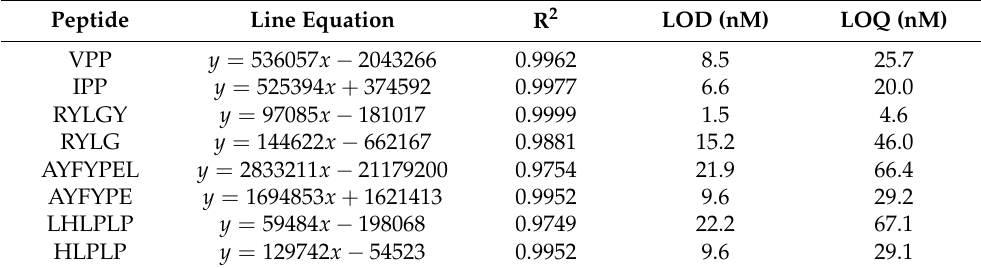
Table 3. Calibration curves obtained for the standard peptides. R 2 is the correlation coefficient of the calibration curve. LOD and LOQ are the Limit of Detection and the Limit of Quantification of the compound, respectively.